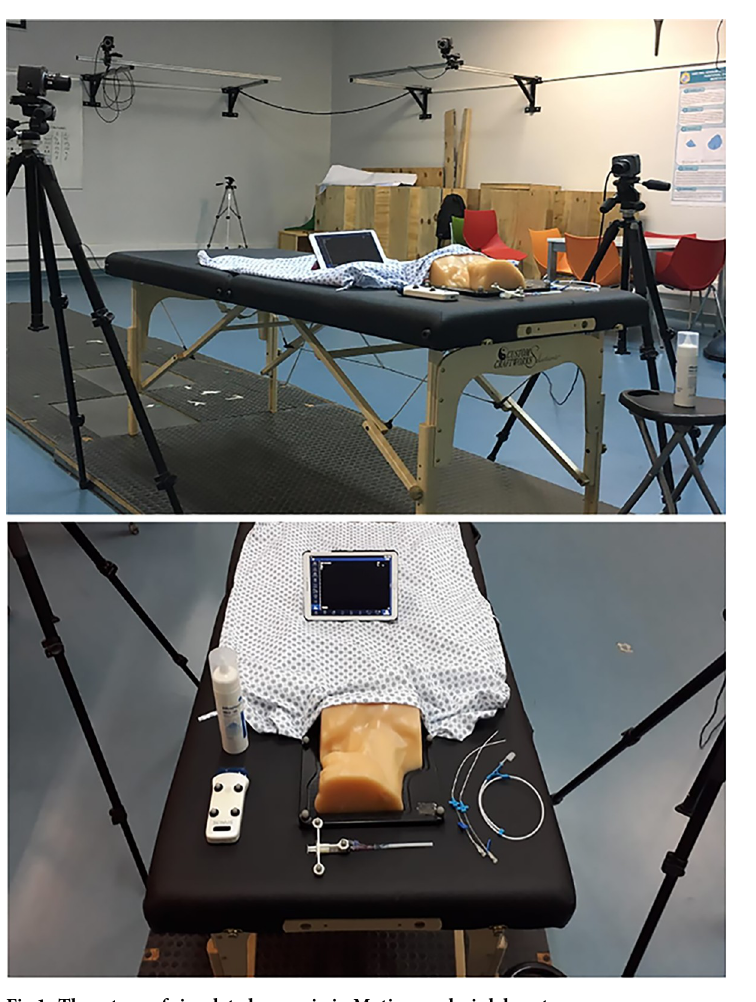
Fig 1. The set-up of simulated scenario in Motion analysis laboratory.